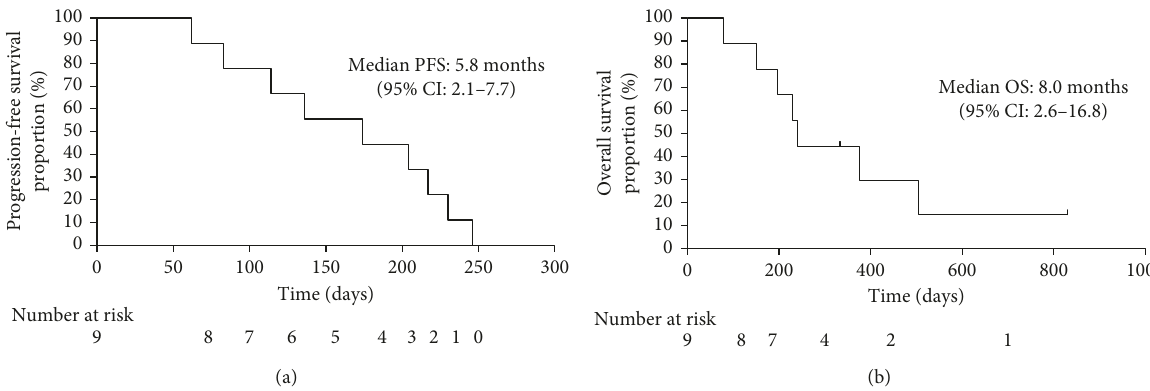
Figure 2: Kaplan–Meier curves of progression-free survival (a) and overall survival (b) in patients with advanced non-small-cell lung cancer (NSCLC) and interstitial lung disease treated with carboplatin plus nab-paclitaxel. OS: overall survival; PFS: progression-free survival; PS: performance status; CI: confidence interval. Table 4: Summary of characteristics of the present study and previous studies using carboplatin plus nab-paclitaxel in patients with advanced non-small-cell lung cancer and with interstitial lung disease in first-line settings.